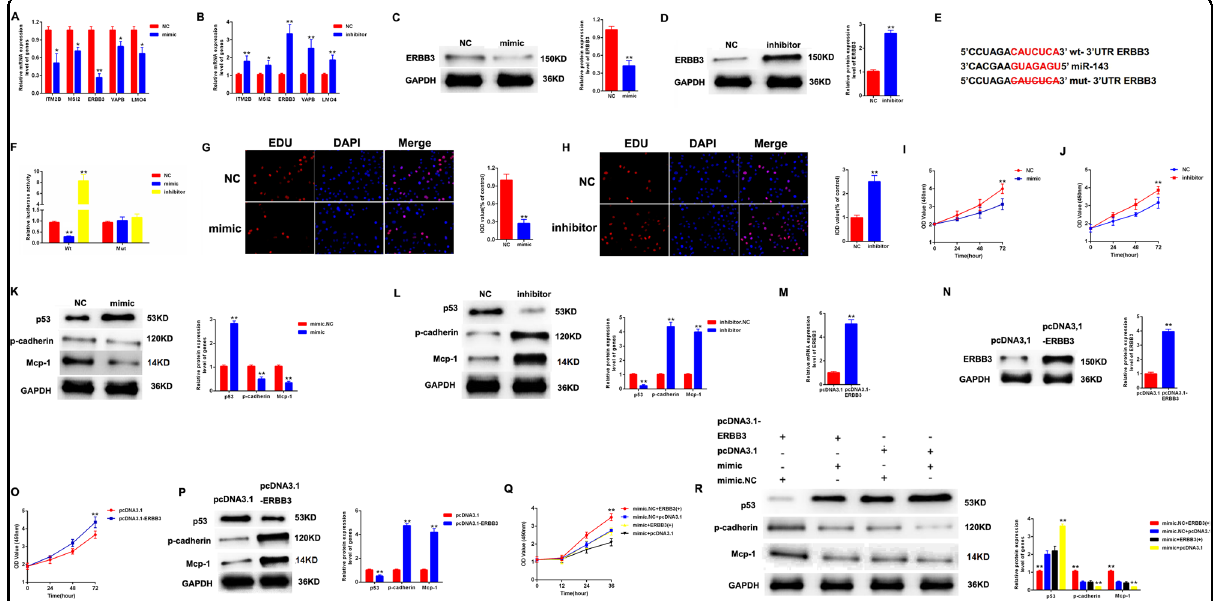
Fig. 4 miR-143 suppressed proliferation and fi brosis of MCs by targeting ERBB3. A Five genes were screened in MCs transfected with mimic- miR-143. B Five genes were screened in MCs transfected with inhibitor-miR-143. C , D The protein expression level of ERBB3 in MCs transfected by mimic-miR-143 or inhibitor-miR-143. E The direct binding sites between miR-143 and ERBB3 were presented. F Luciferase reporter assay was performed to con fi rm the direct binding relationship between miR-143 and ERBB3. G , H Proliferating MCs were labeled with EdU after transfection with mimic-miR-143 or inhibitor-miR-143. I , J Proliferating MCs were labeled with CCK-8 after transfection with mimic-miR-143 or inhibitor-miR-143. K , L The protein expression level of p-53, p-cadherin, and Mcp-1 in MCs transfected with mimic-miR-143 or inhibitor-miR-143. M , N Ef fi ciency of pcDNA3.1-ERBB3 were con fi rmed by qPCR and western blotting. MCs were transfected with pcDKDA3.1-ERBB3 or vector. O CCK-8 assay was carried out to evaluate cell proliferation. MCs were transfected with pcDNA3.1-ERBB3 or vector. P p-53, p-cadherin, and Mcp-1 protein expression in MCs transfected with pcDNA3.1-ERBB3 or vector. Q The growth of MCs was detected after transfected by mimic-miR-143 or pcDNA3.1-ERBB3. R p-53, p-cadherin, and Mcp-1 protein expression in MCs transfected by mimic-miR-143 or pcDNA3.1-ERBB3. Three independent experiments were conducted. Error bars stand for the mean ± SD of at least triplicate experiments; * P < 0.05, ** P <